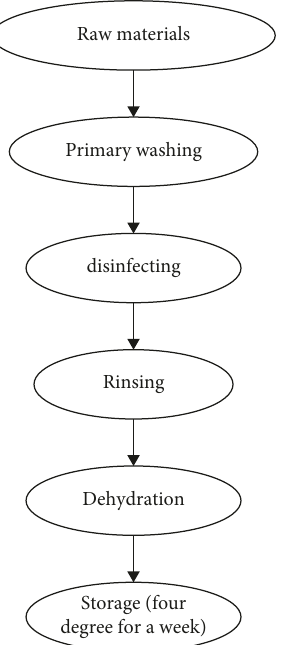
Figure 2: The preprocessing steps of edible vegetable